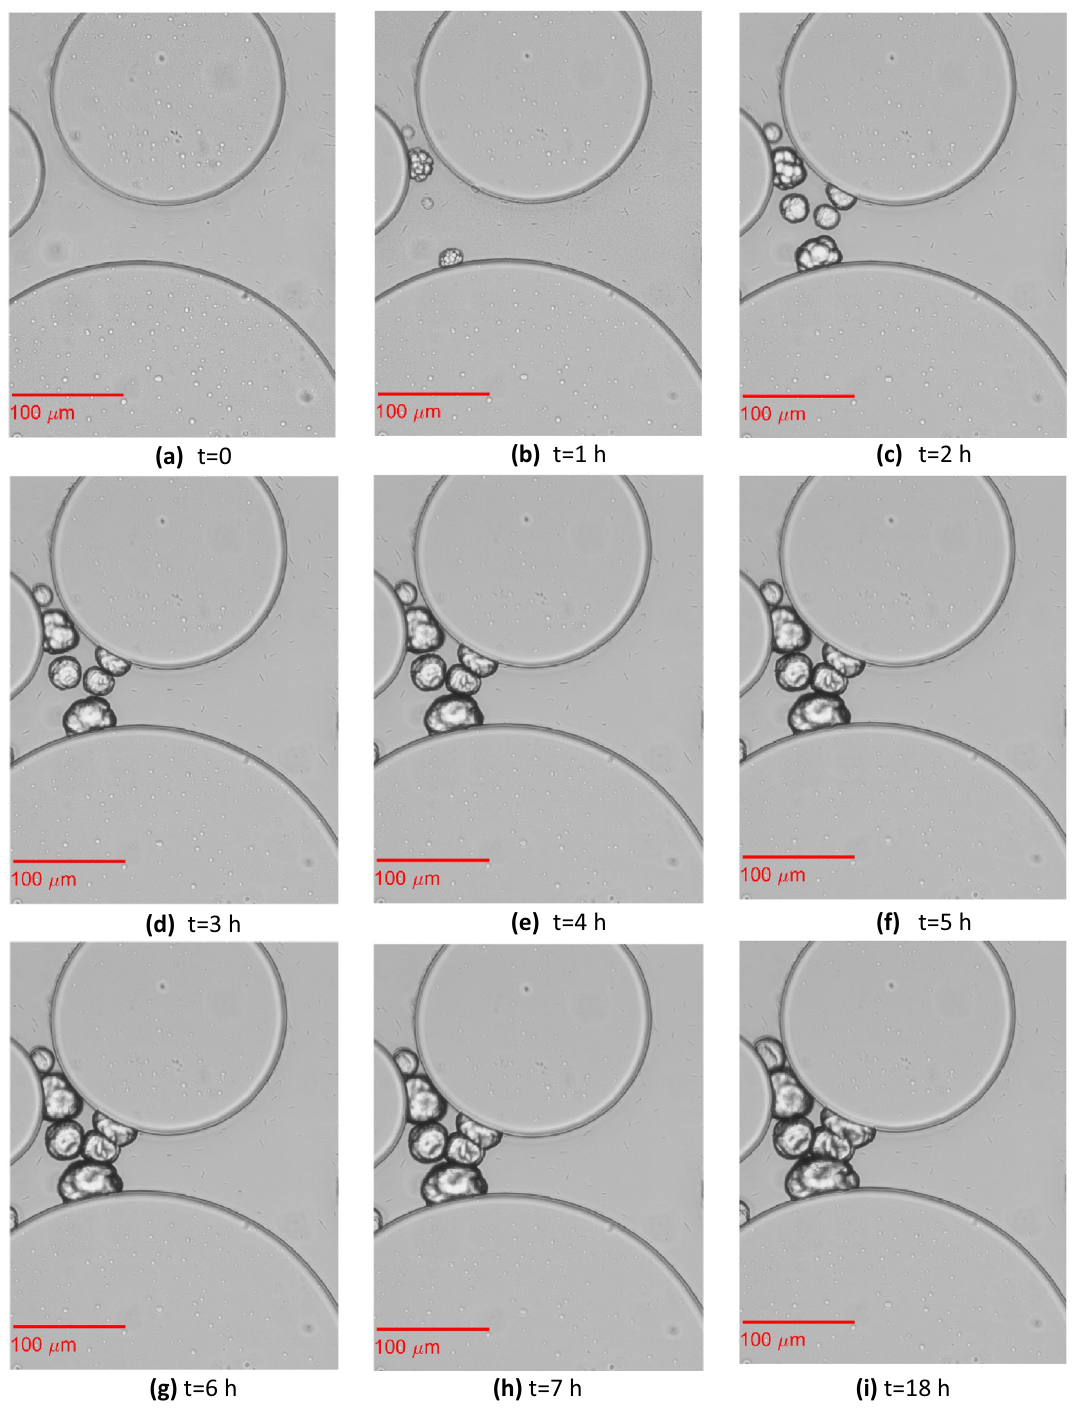
Figure 8. Evolution of crystal aggregation in the pore space among three cylindrical solid grains of the heterogeneous replica of a porous medium. This pore is located in a sampled location ~730 mm from the